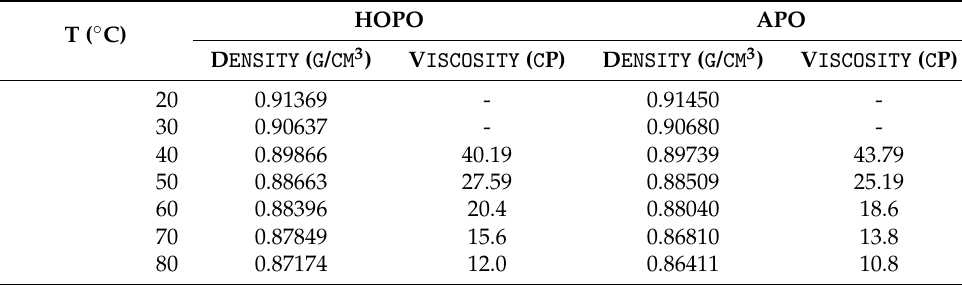
Table 2. Densities and viscosities of palm oils as a function of temperature *.